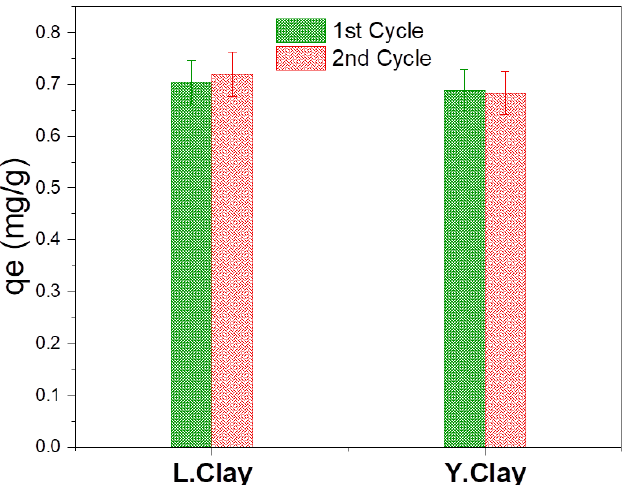
Figure 12. Regeneration and reuse test for L. Clay and Y. Clay for the adsorption of crystal violet dye (C 0 = 5 mg/L; T = 10 °C; m Clay /V solution = 4 mg/mL).